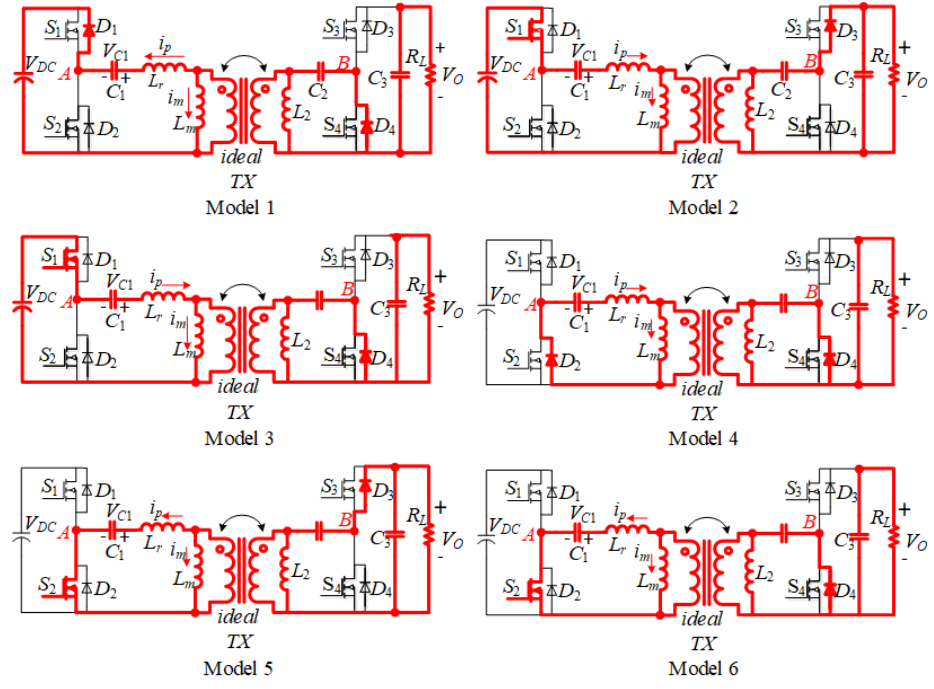
Figure 6. Forward working mode state diagrams.